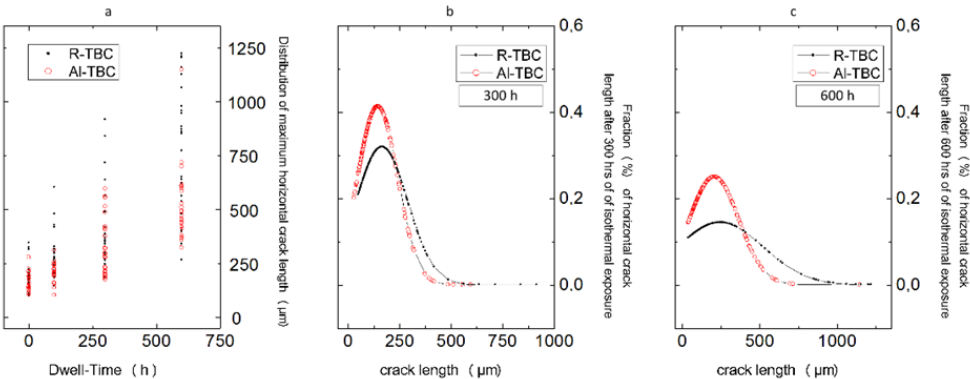
Figure 8. The effect of holding time at 1150 °C on the maximum horizontal crack lengths in the R-TBC and Al-TBC systems: ( a ) distribution of the maximum horizontal crack length with respect to the holding time; ( b ) normal distribution of the maximum horizontal crack length after 300 h of isothermal exposure at 1150 °C; and ( c ) normal distribution of the maximum horizontal crack length after 600 h of isothermal exposure at 1150 °C.